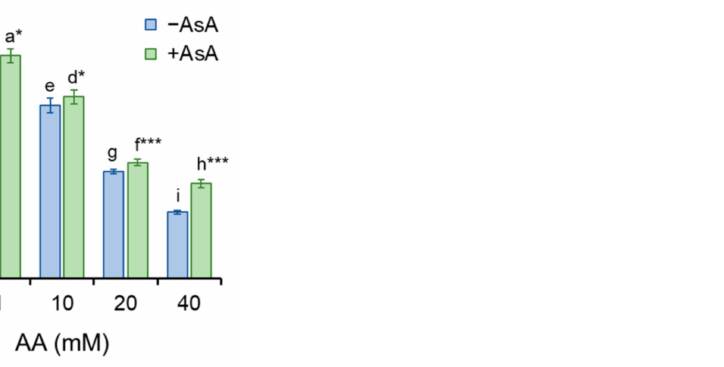
Figure 3. Metabolic activity. Metabolic activity determined as formazan production, detectable at 485 nm and normalized to protein unit, from yellowish tetrazolium chloride (TTC), indicates functionality of mitochondria, thereby indirectly representing cell vitality. Individual bars represent mean value of 8 samples from two independent experiments ± SD. Statistical significance, determined by Duncan’s post-hoc test, was set up as p < 0.05 *, 0.01 **, 0.001 *** different letters above bars indicate statistical difference.